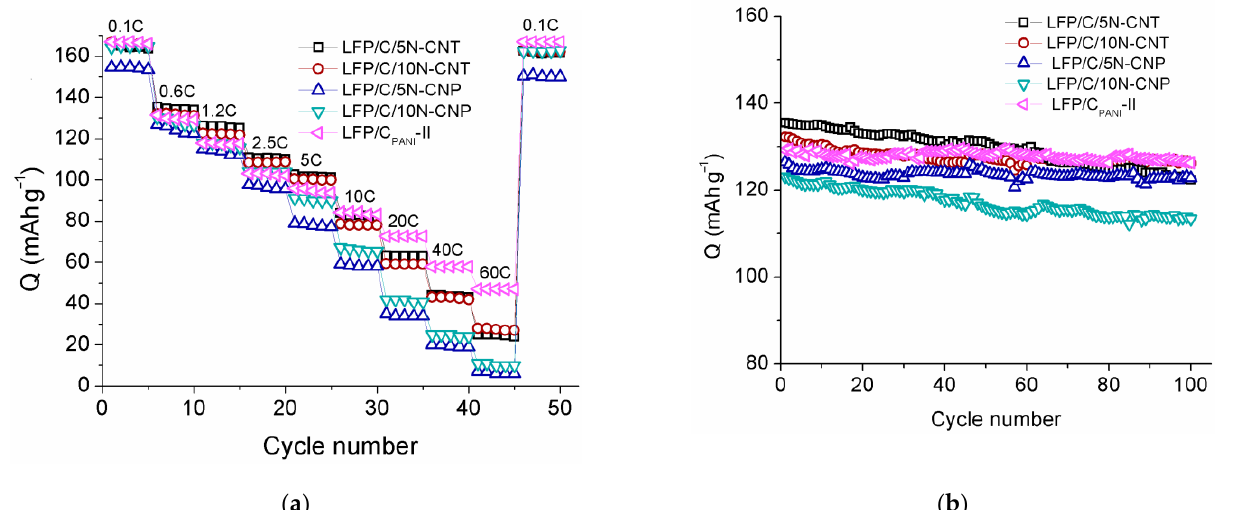
Figure 7. Change of discharge capacity during cycling of LFP/C/5N-CNT, LFP/C/10N-CNT, LFP/C/5N-CNP, LFP/C/10N-CNP, and LFP/C PANI -II ( a ) and their long-term cycling performance at a 0.6 C-rate ( b ).